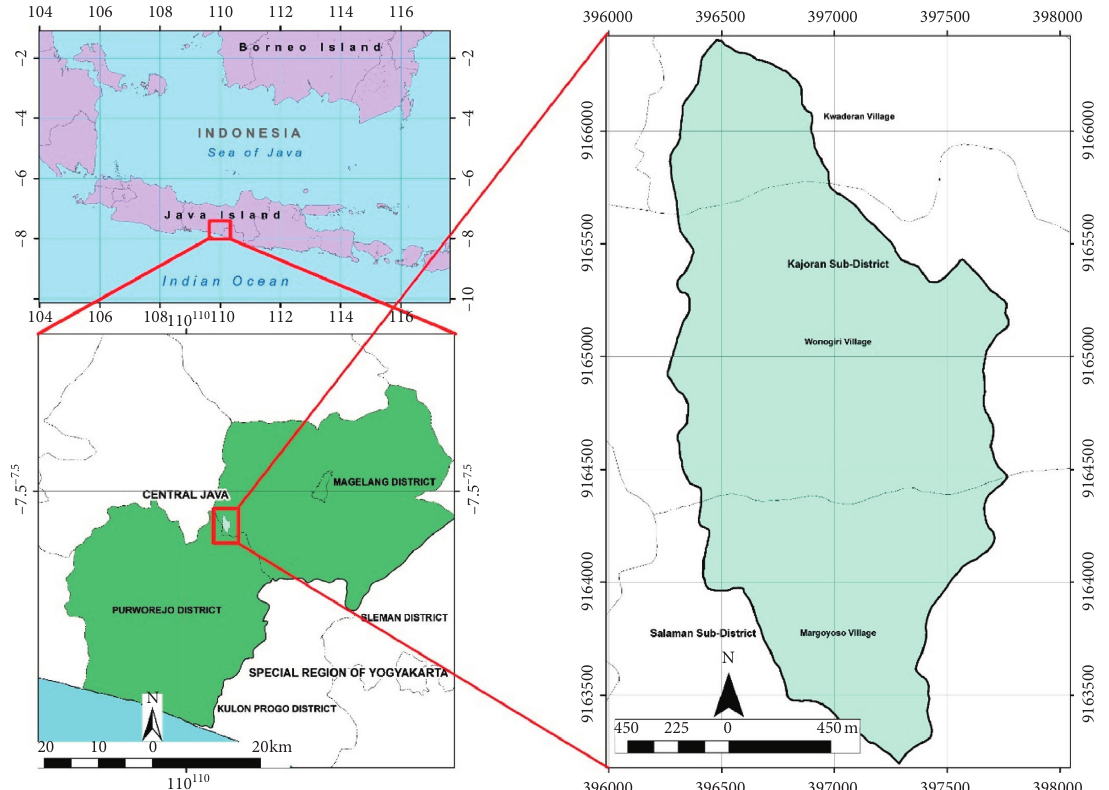
Figure 1: Location of Bompon watershed. Sits near the border between Magelang and Purworejo District, Central Java, Indonesia.